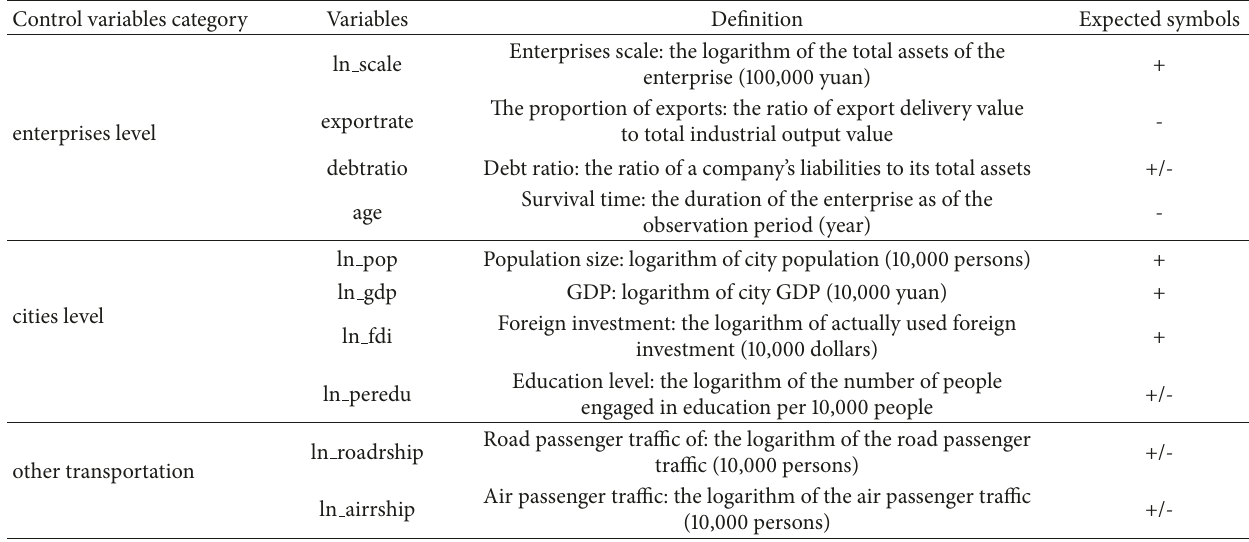
Table 1: Control variable definitions and expected symbols.